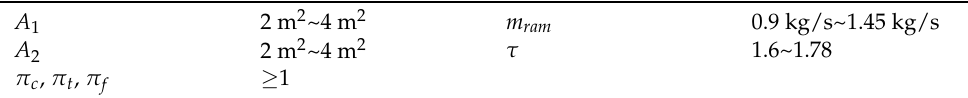
Table 3. Value ranges for design